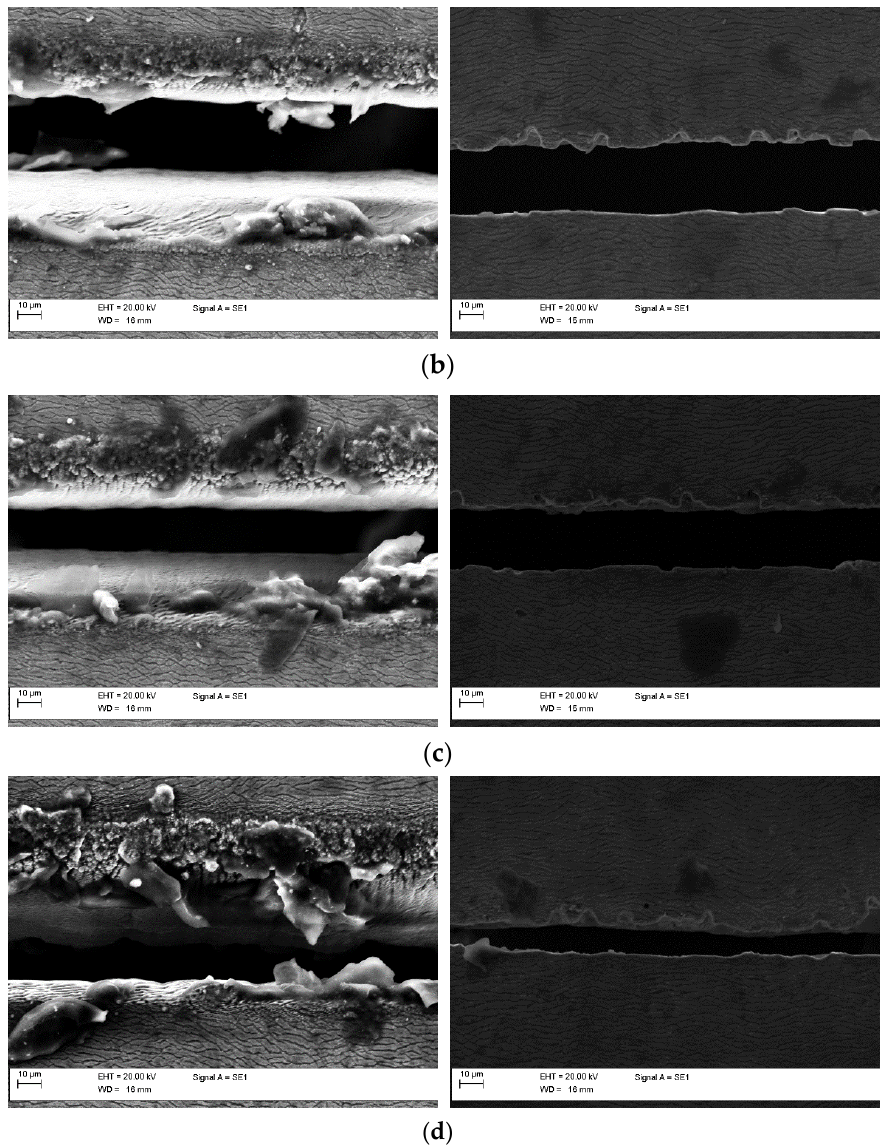
Figure 4. SEM images of the entry and exit kerfs at varying numbers of laser passes on the cold- worked NiTi sheet: ( a ) P = 10 W; v = 550 mm/s; n = 100; P = 10 W; ( b ) v = 550 mm/s; n = 125; ( c ) P = 10 W; v = 550 mm/s; n = 150; ( d ) P = 10 W; v = 550 mm/s; n = 175.